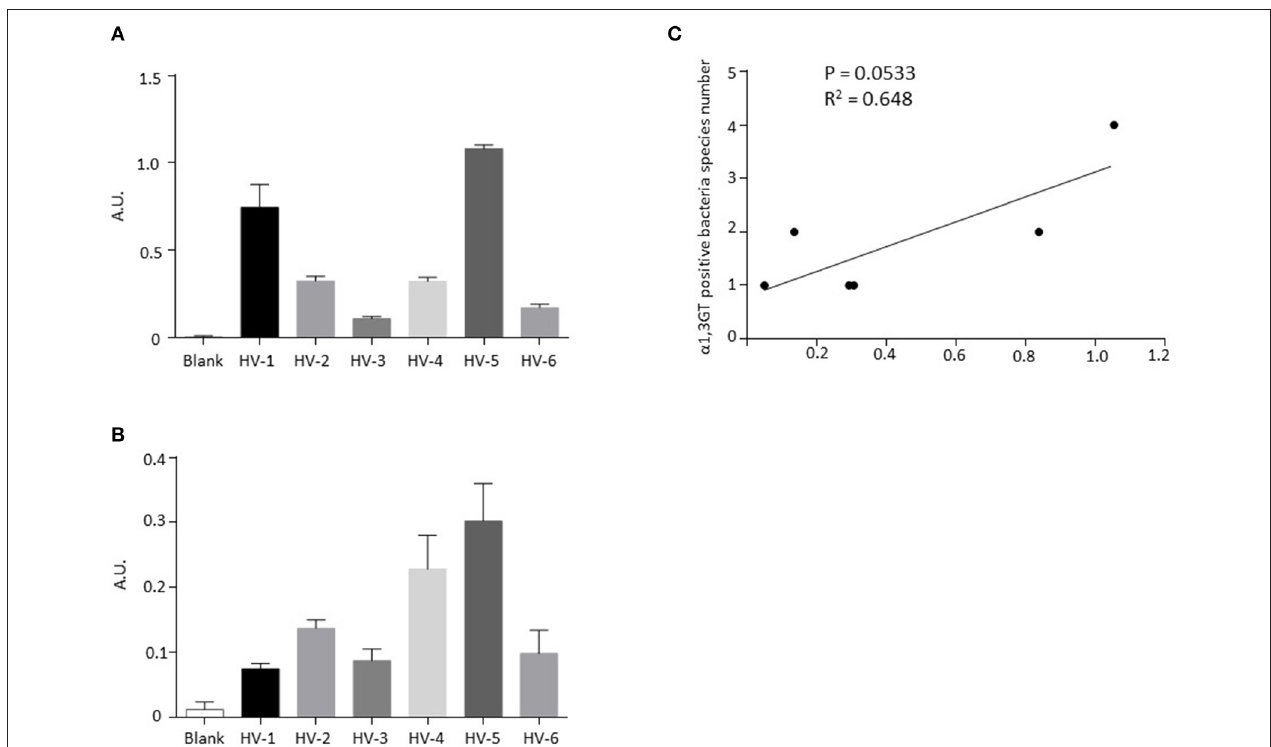
FIGURE 3 | Detection of α 1,3-Gal antigen and α 1,3GT activity in stools from healthy donors exhibiting bacterial α 1,3GT gene sequences in their shotgun analysis. (A) Levels of α 1,3-Gal antigen detected by ELISA in stools from 6 healthy volunteers. (B) Activity of α 1,3GT enzymes detected by ELISA in stools from six healthy volunteers. (C) Correlation between the number of detected bacteria species harboring α 1,3GT gene sequences and the amounts of Gal antigen in stools.